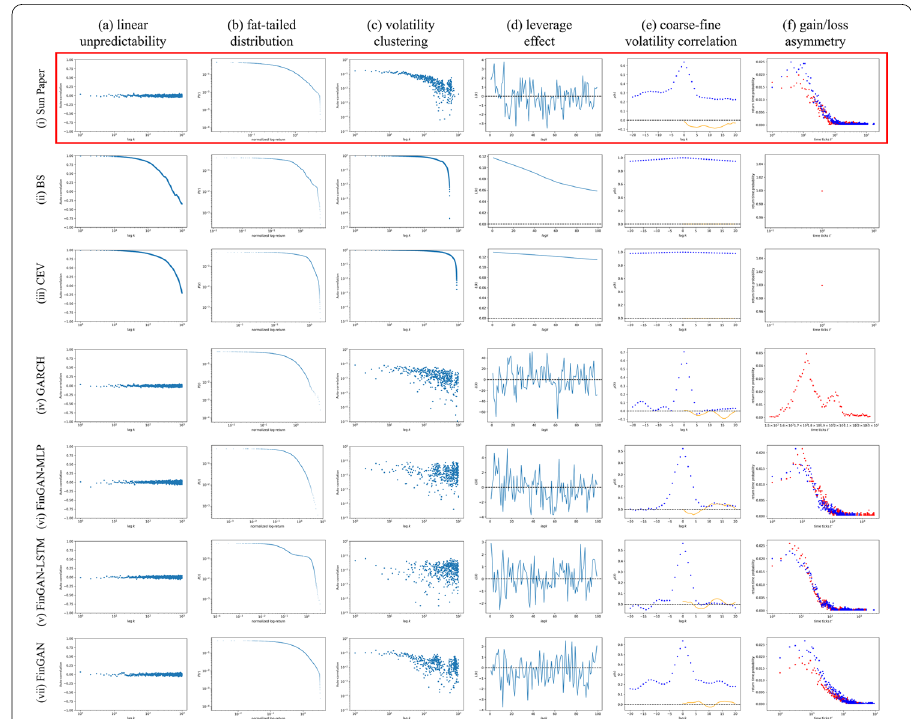
Fig. 4 Statistical properties for the return process of the Sun Paper and return process generated by BS, CEV, GARCH, FinGAN-MLP, FinGAN-LSTM and FinGAN models. ( a ) Linear unpredictability is shown as the zero level of the auto-correlation function of the price return is at zero level for all lags. ( b ) Fat-tailed distribution is demonstrated by the power-law decay of the tails of the probability distribution. ( c ) Volatility clustering is expressed by the slow decay of the auto-correlation function for the absolute values of the price return. ( d ) Leverage effects are shown as the lead-lag correlation of the price return and the price volatility. ( e ) Coarse-fine volatility correlation is shown as the lead-lag correlation of the coarse and the fine volatility. ( f ) Gain/loss asymmetry is shown in the difference of the probability distributions for the time-step required to reach a certain positive (red) and negative (blue) price change. The sample period is from November 16,